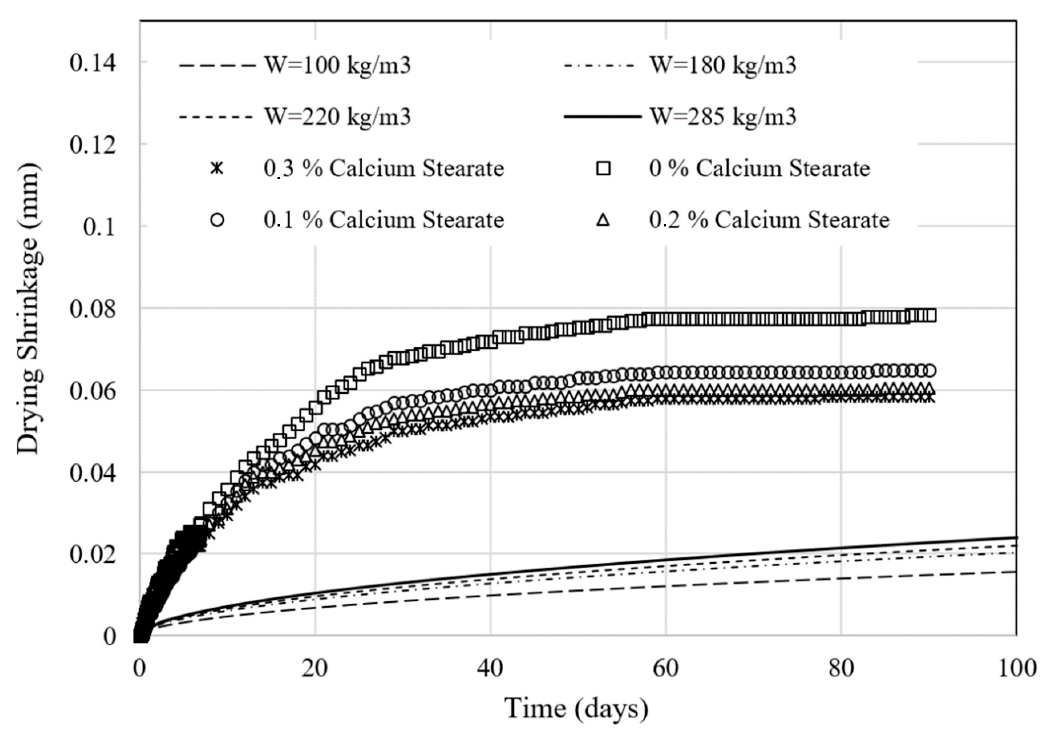
Figure 6. Drying Shrinkage and density of specimens.